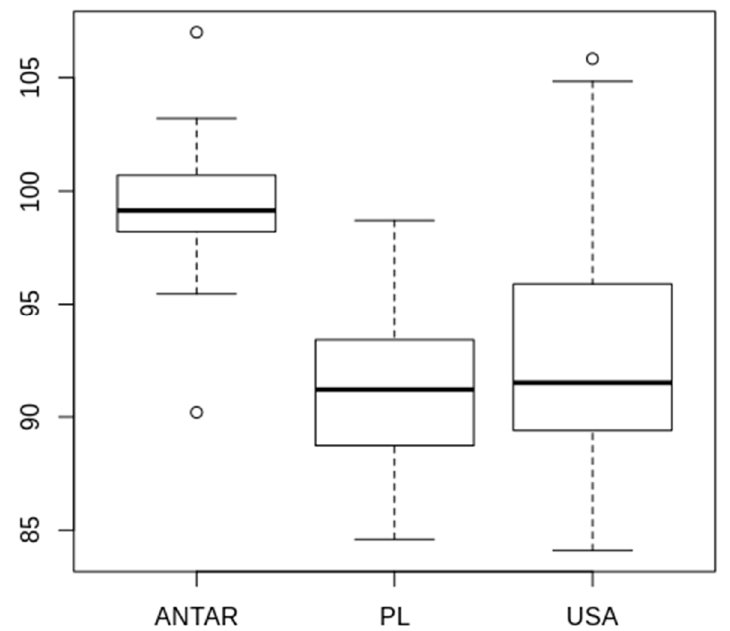
Figure 10. Differences in the egg bare diameter between the studied populations of Paramacrobiotus fairbanksi Schill, Förster, Dandekar and Wolf [25] (Antar, Antarctic; PL, Poland; USA, USA). Minimum, maximum, median, first quartile, and third quartile for each population are presented.